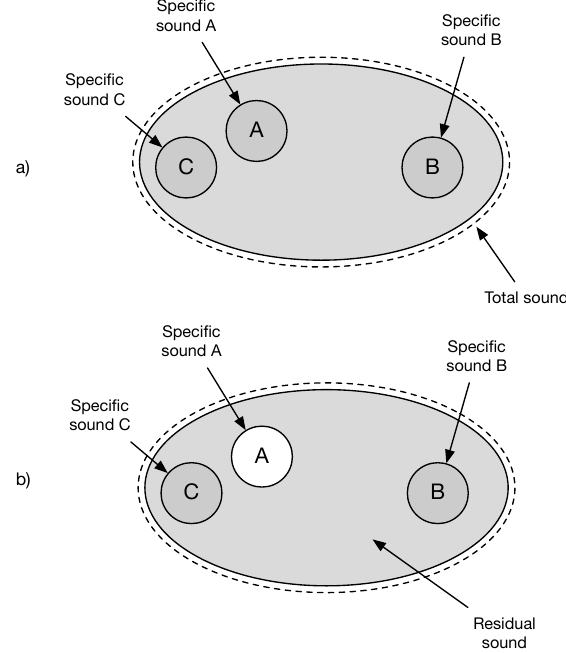
Figure 1. Total, specific and residual sound. 3 sources A, B and C are identified but other non identified sources combine into the total sound ( a ). With respect to A, the residual sound is observed when the specific sound A is absent ( b ), everything else being